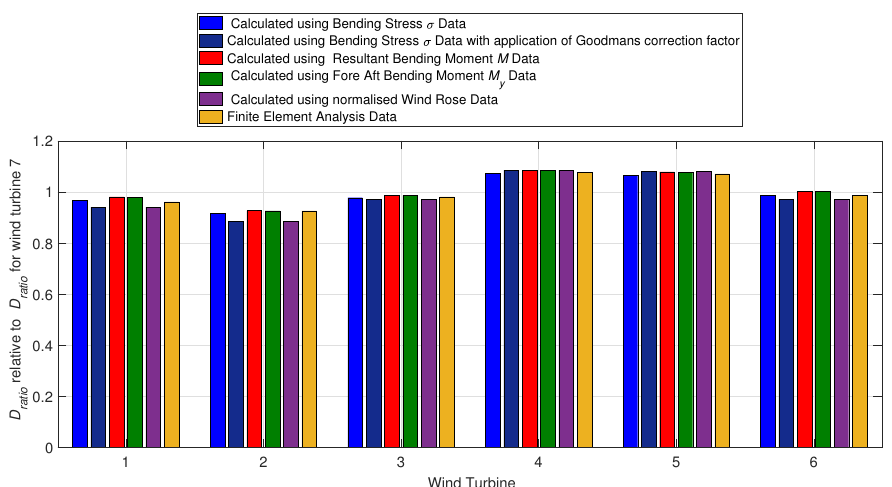
Figure 27. Normalised D ratio results for a range of scenarios compared to relative D ratio calculated using finite element analysis for a range of wind turbines.